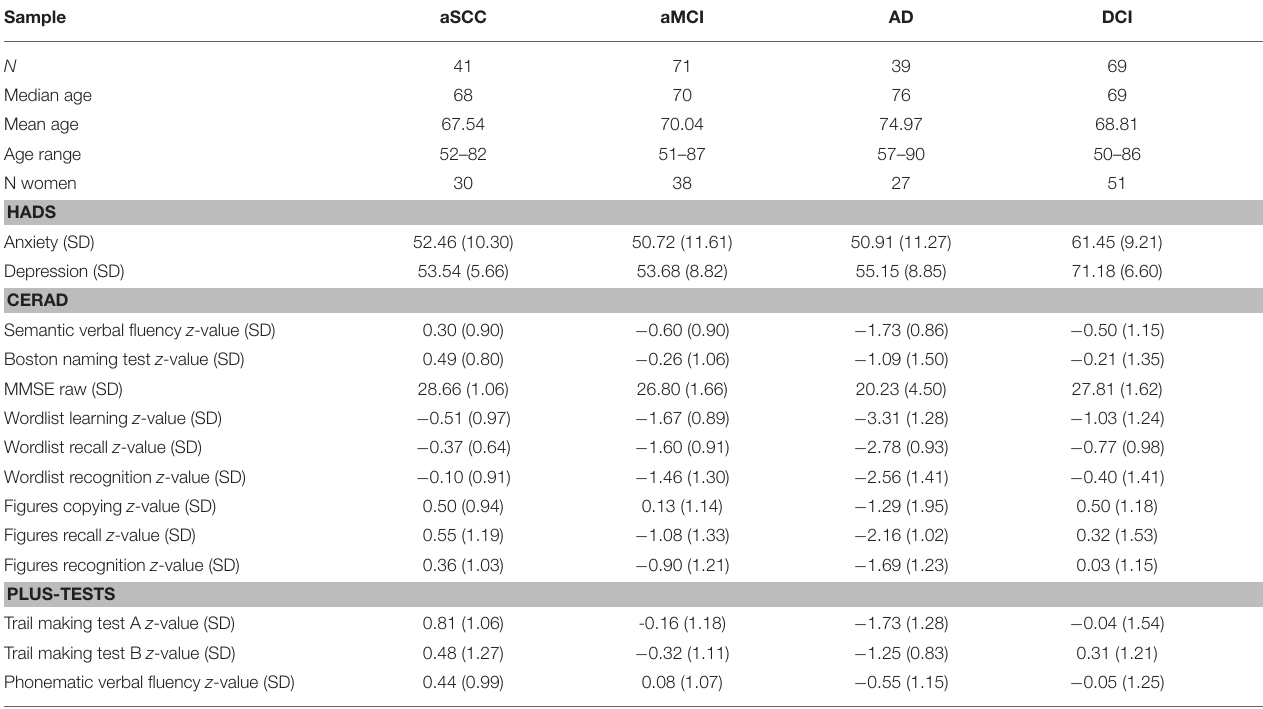
TABLE 1 | Sample overview with means and standard deviations in parentheses for neuropsychological test results.